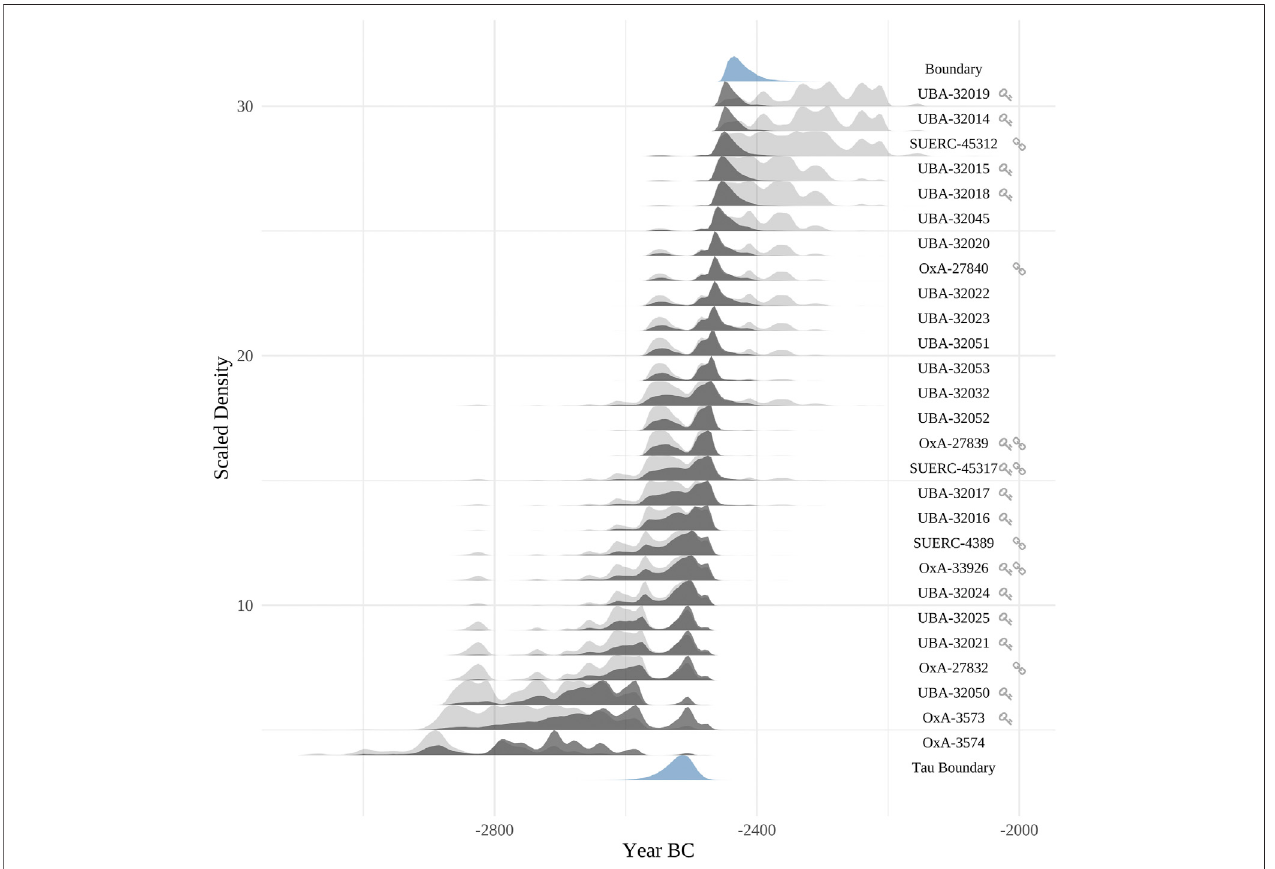
FIGURE 8 | Chronological modelling of radiocarbon dates associated with fragments of the broken Xag ħ ra Circle statue. Blue distributions show start and end point of the preferred model in Oxcal. Key symbol shows samples from key contexts, link symbol shows samples which are from articulated remains.